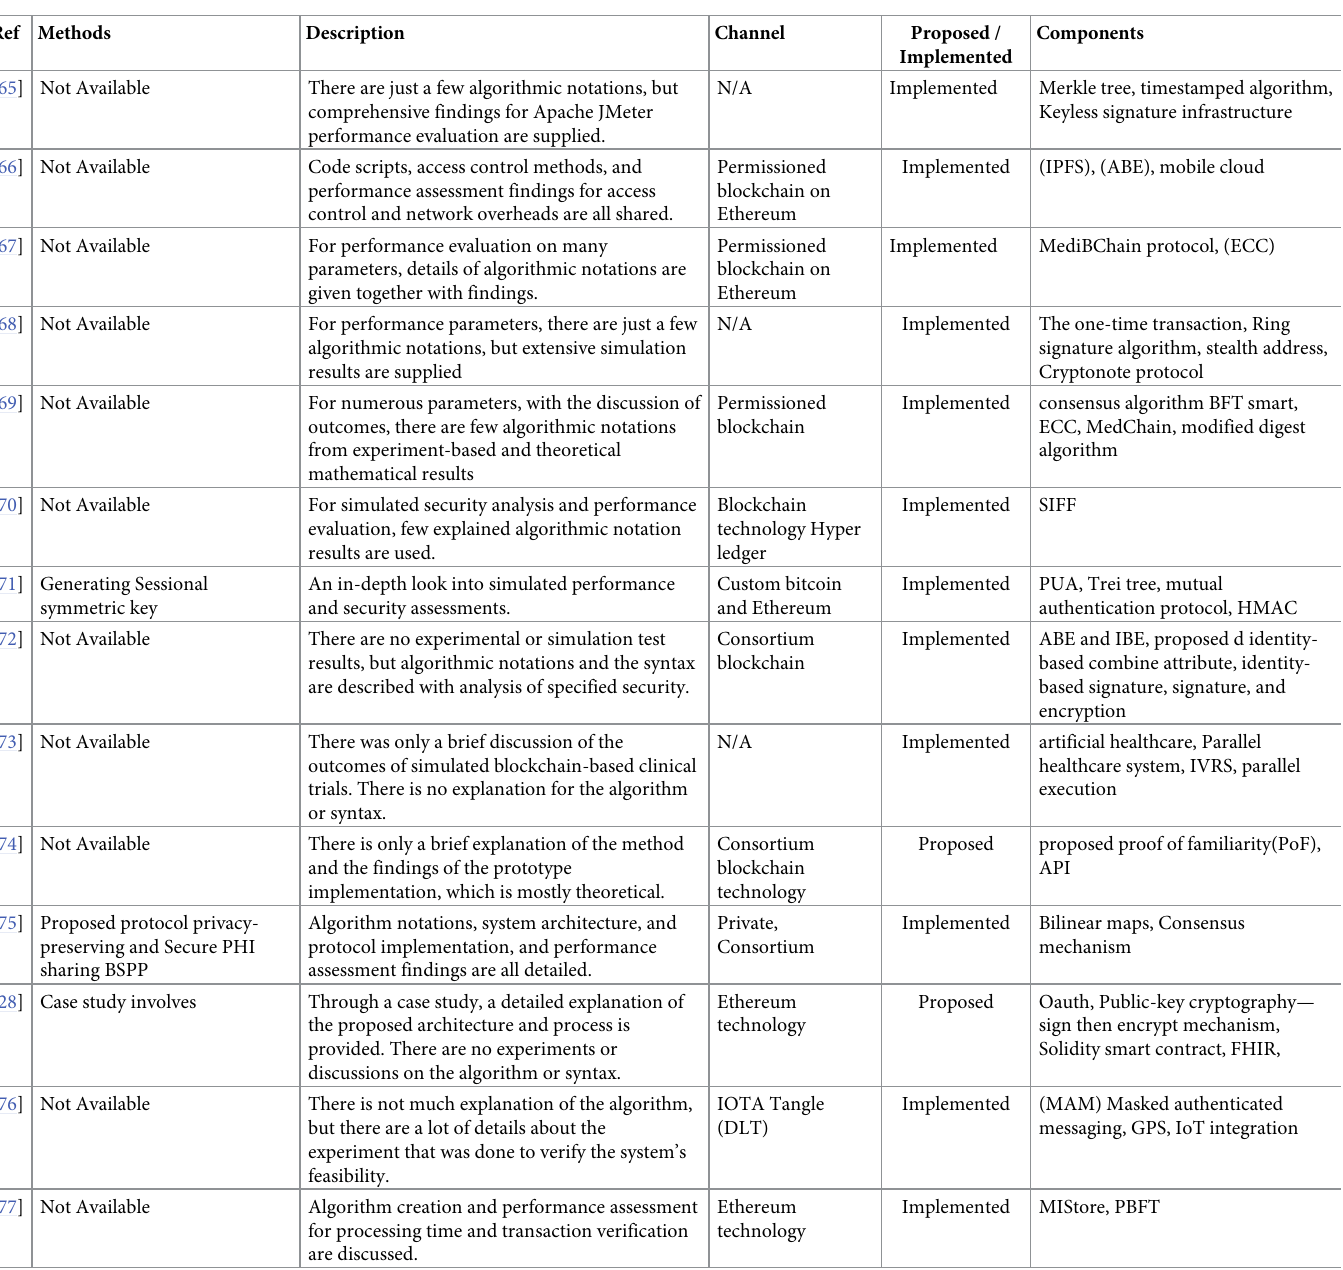
Algorithm notations, system architecture, and protocol implementation, and